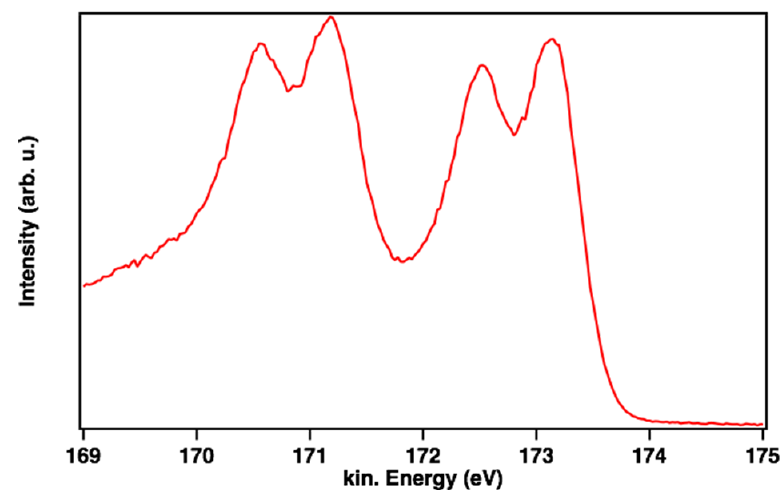
Figure 1: Ta 4f lines of TaS cooled to ~25 K using 200 eV photons. The spin-orbit split doublet is 2 accompanied by an additional charge density wave (CDW) splitting.